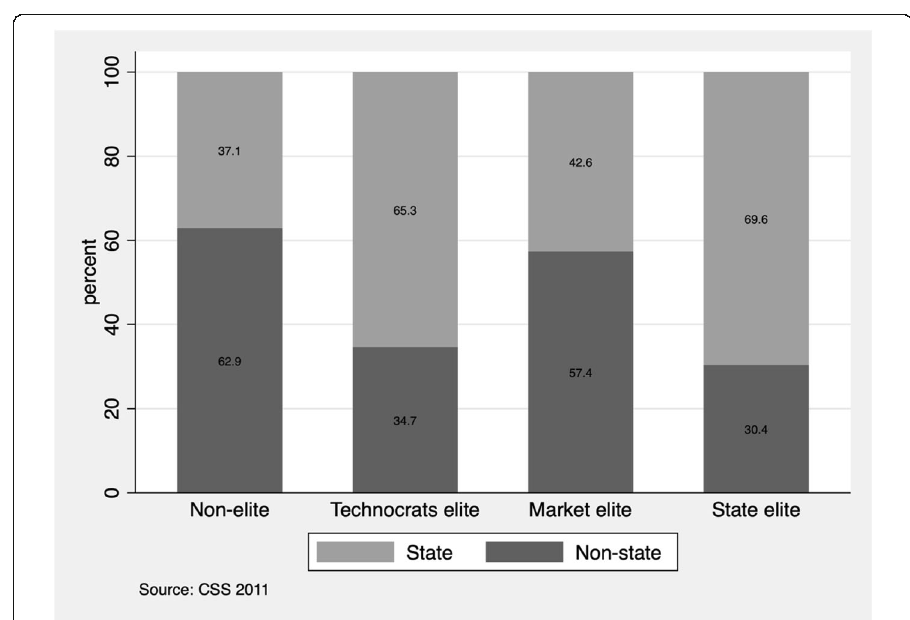
Fig. 1 Distribution of first job sector by family